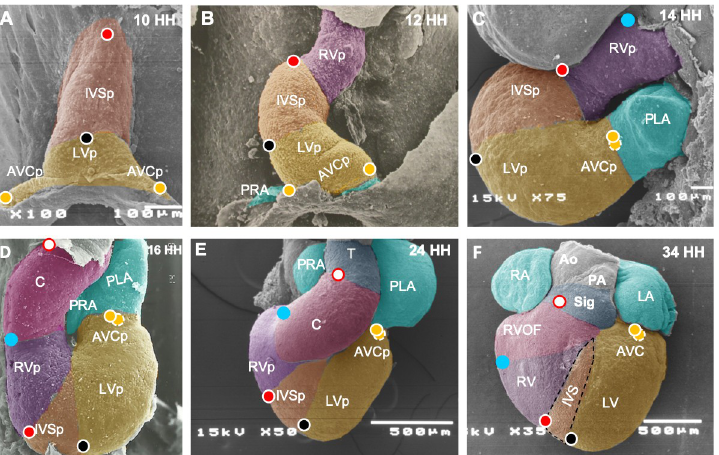
Fig 5. New proposal for the segmental pattern of the heart tube during torsion and looping. (A) Straight heart tube. (B) “C” loop. (C) “S” loop. (D) “U” loop. (E) Middle stage of cardiac septation. (F) Mature heart. Anterior segment of the straight heart tube corresponds to the primordium of the interventricular septum (IVSp). Posterior segment is composed of precursors of the left ventricle (LV) and atrioventricular canal (AVC). The segment classically considered the conus of the C-looped heart, actually participates in the complete right ventricle (RV) development. The region previously considered the RV primordium actually participates in the development of the middle and apical thirds of the interventricular septum. The supposed left ventricular primordium actually contributes cell populations to the development of LV and AV canal. Abbreviations: AVCp, atrioventricular canal primordium; C, conus; LA, left atrium; LVp, left ventricle primordium; RA, right atrium; RVOF, right ventricle outflow; PLA, primitive left atrium; PRA, primitive right atrium; RVp, right ventricle primordium; Sig, sigmoid valves; T, truncus.